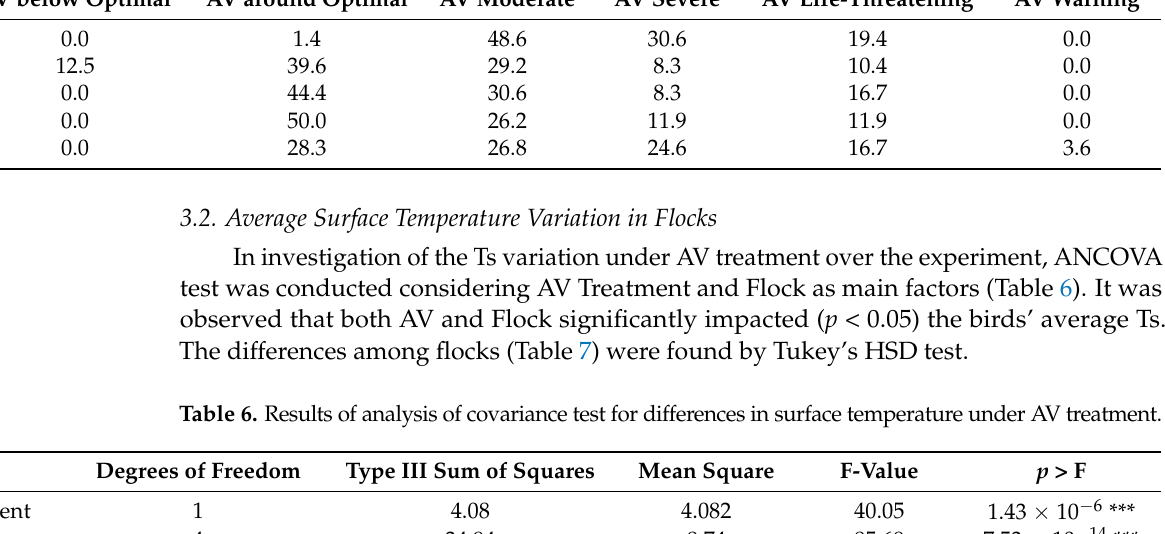
Table 5. Distribution of AV treatments implemented from 35 d to 61 d during the image-capturing time. % of Occurrences